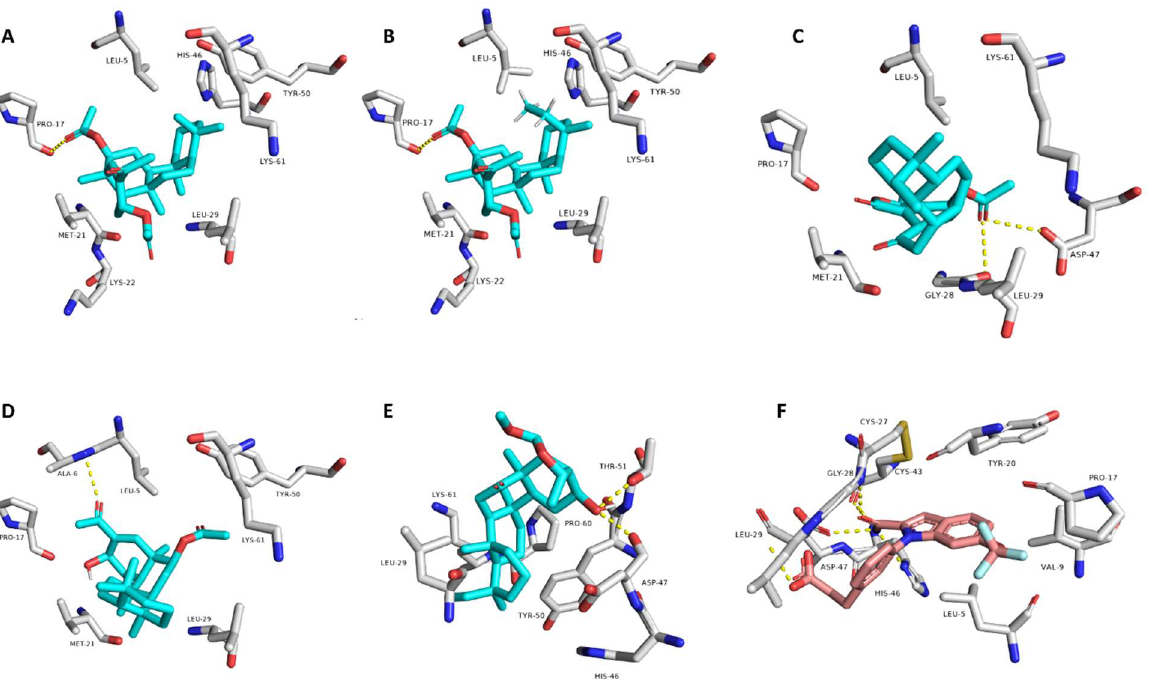
Figure 6. Predicted binding modes of compounds 1, 2, 8, 10, and 15 ( A – E , respectively) inside sPLA2 (PDB code: 5OWC), alongside the co-crystalized inhibitor ( F ).